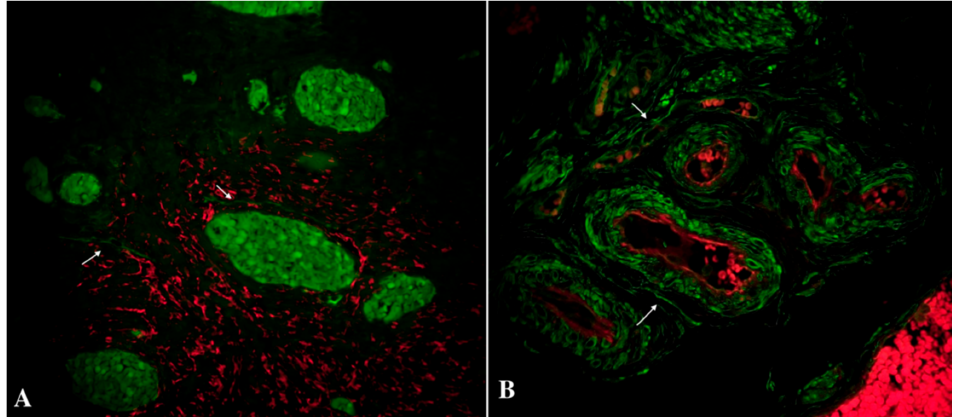
Figure 5. Samples of human oviduct stained for CD31 (red, Alexa Fluor 594) and CD 34 (green, Alexa Fluor 488) in the control ( A ) and study ( B ) groups. The doubly immunopositive structure was identified as vessel, while the cell with an elongated body located between muscle fibers and close to the blood vessel was identified as a telocyte (one of them is indicated by arrows on the image). The telocytes on the right image are located close to blood vessels of different calibers.